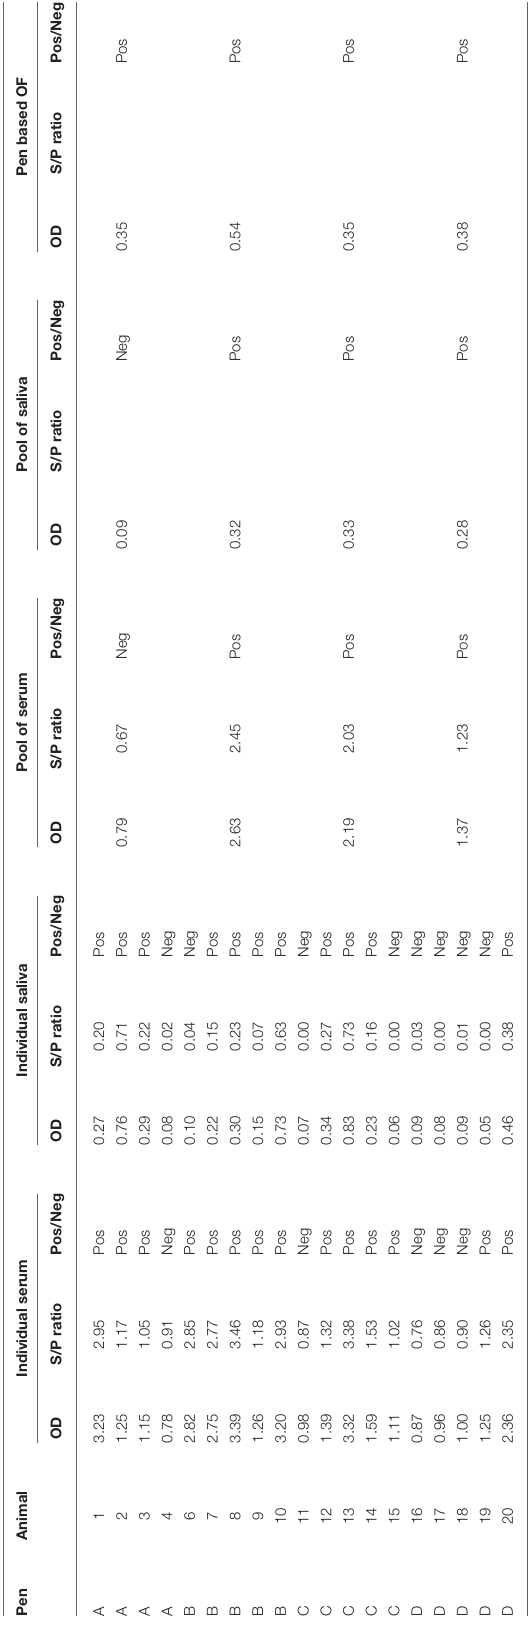
two seropositive pigs had saliva samples that yielded negative ELISA